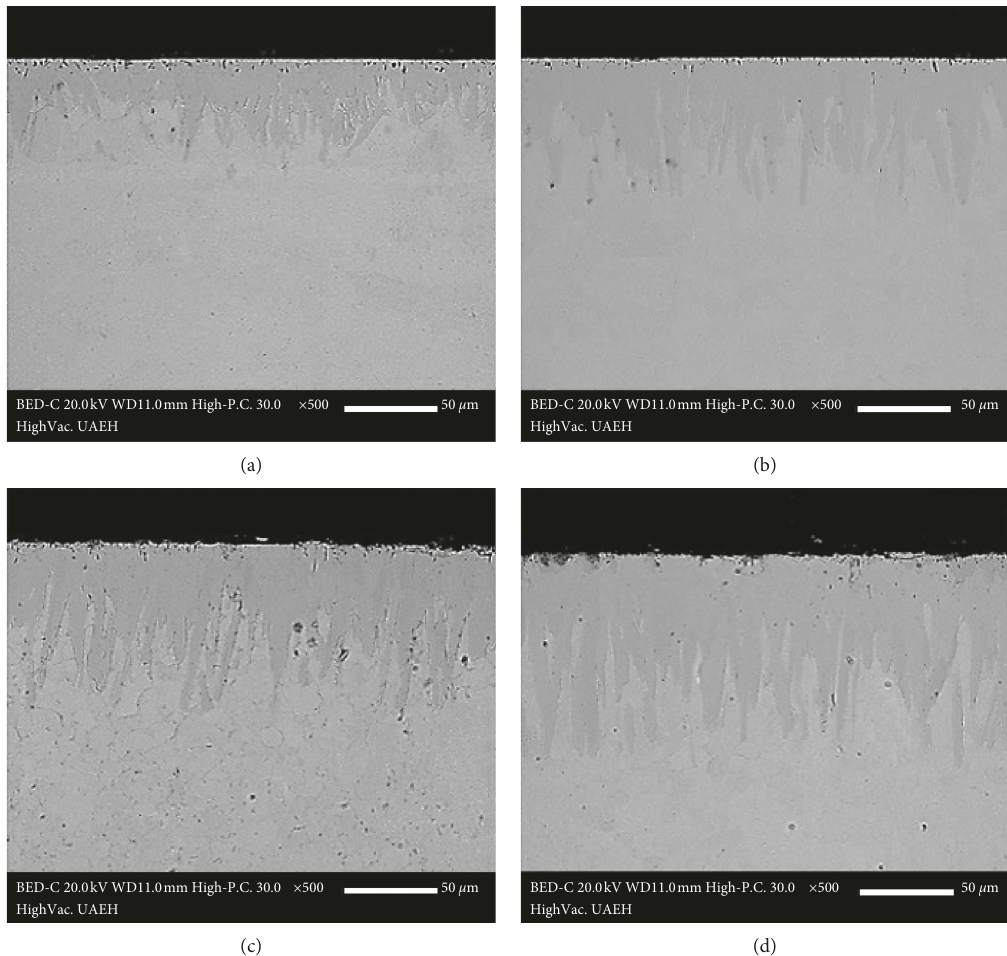
Figure 3: SEM micrographs of the cross sections of ASTM A36 steel samples borided at 1123 K during different exposure times: (a) 2 h, (b) 4h, (c) 6 h, and (d)